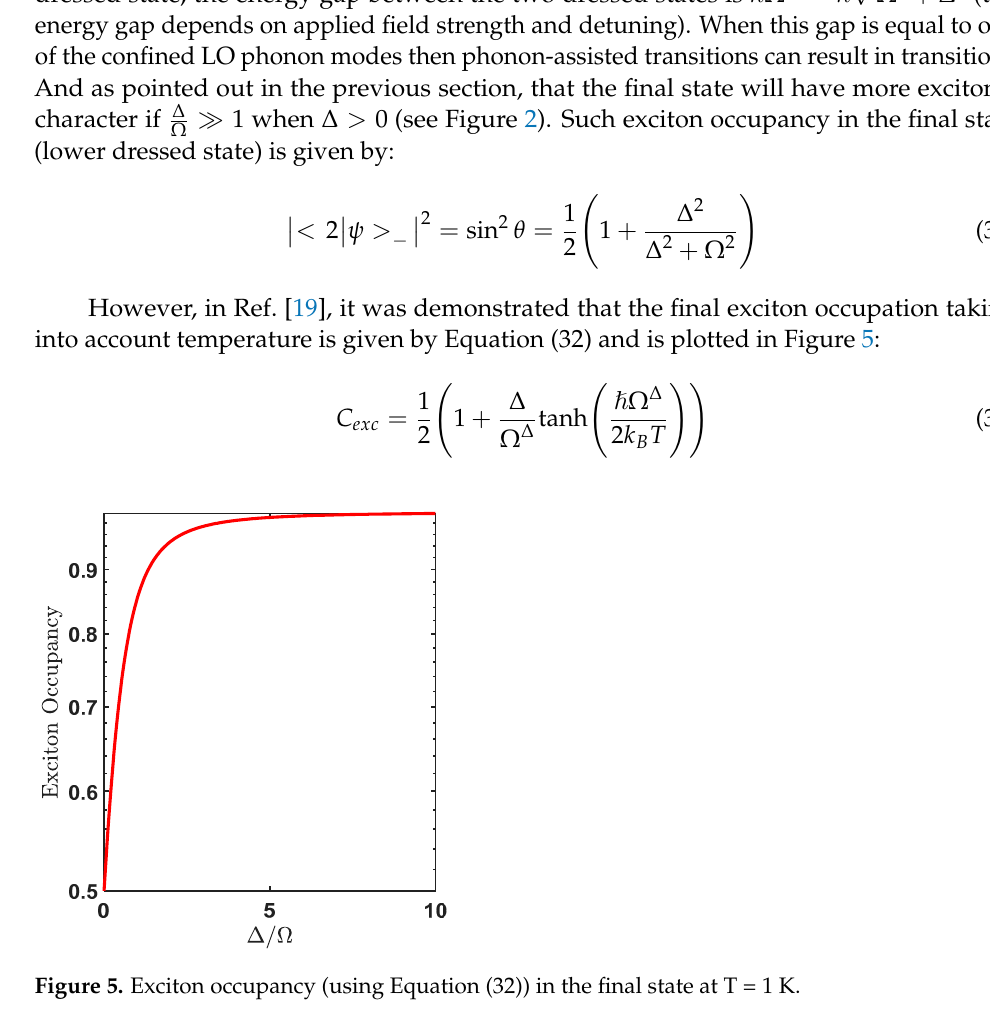
Figure 4. Phonon assisted transition rate between the dressed state for GaAs QD of radius 3.39 nm at T = 1 K. (Red line: confined LO phonon 𝑛 = 1 mode contribution to transition rate, Black line (dashed): bulk acoustic phonon contribution to transition rate)